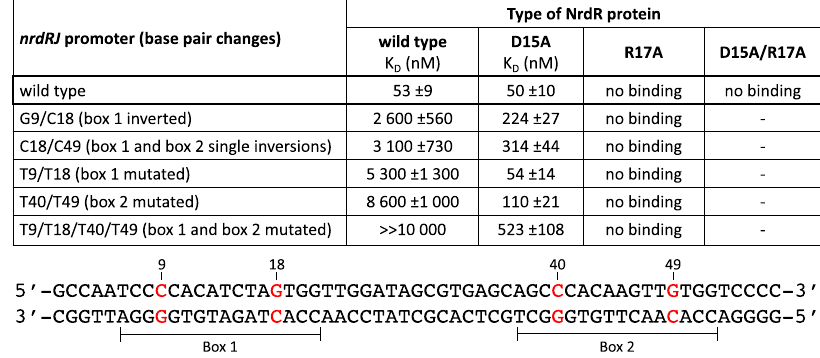
Fig. 4 Importance of highly conserved GC base pairs in the nrdRJ NrdR boxes and two conserved residues in the NrdR protein. Upper panel: Results of MST experiments performed in the presence of 1 mM dATP and 1 mM ATP. A binding constant of »10 µ M indicates a K D between 19 and 96 µ M; a minus sign means that no experiment was performed. Lower panel: Mutated base pairs (red) in the 57 bp nrdRJ